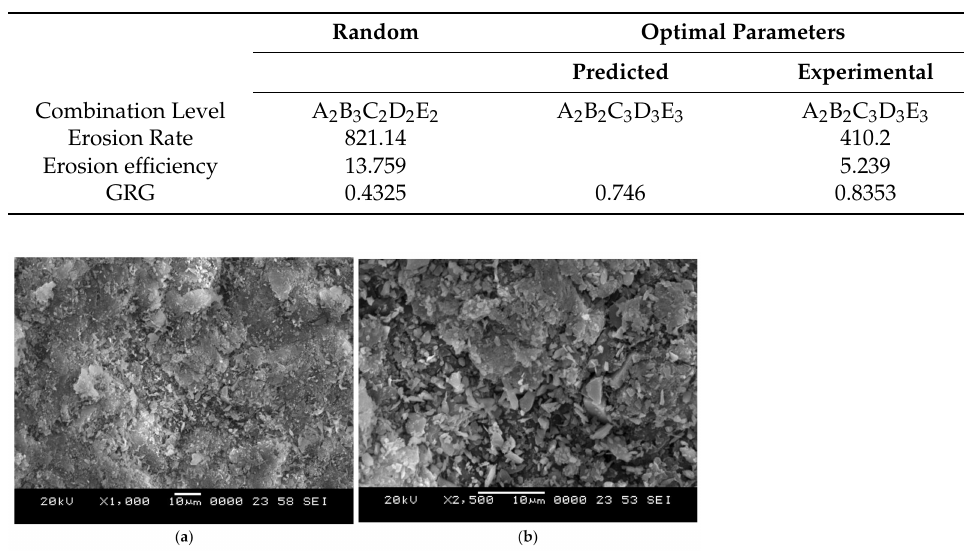
Table 6. Results of confirmation experiment.